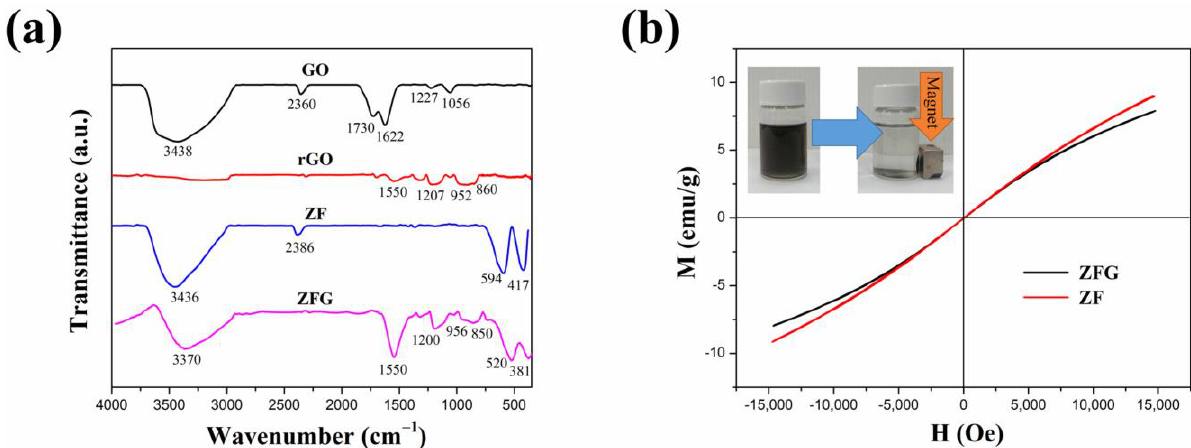
Figure 3. ( a ) FT-IR spectra of GO, rGO, ZF, and ZFG and ( b ) magnetization hysteresis loops of ZFG and ZF.